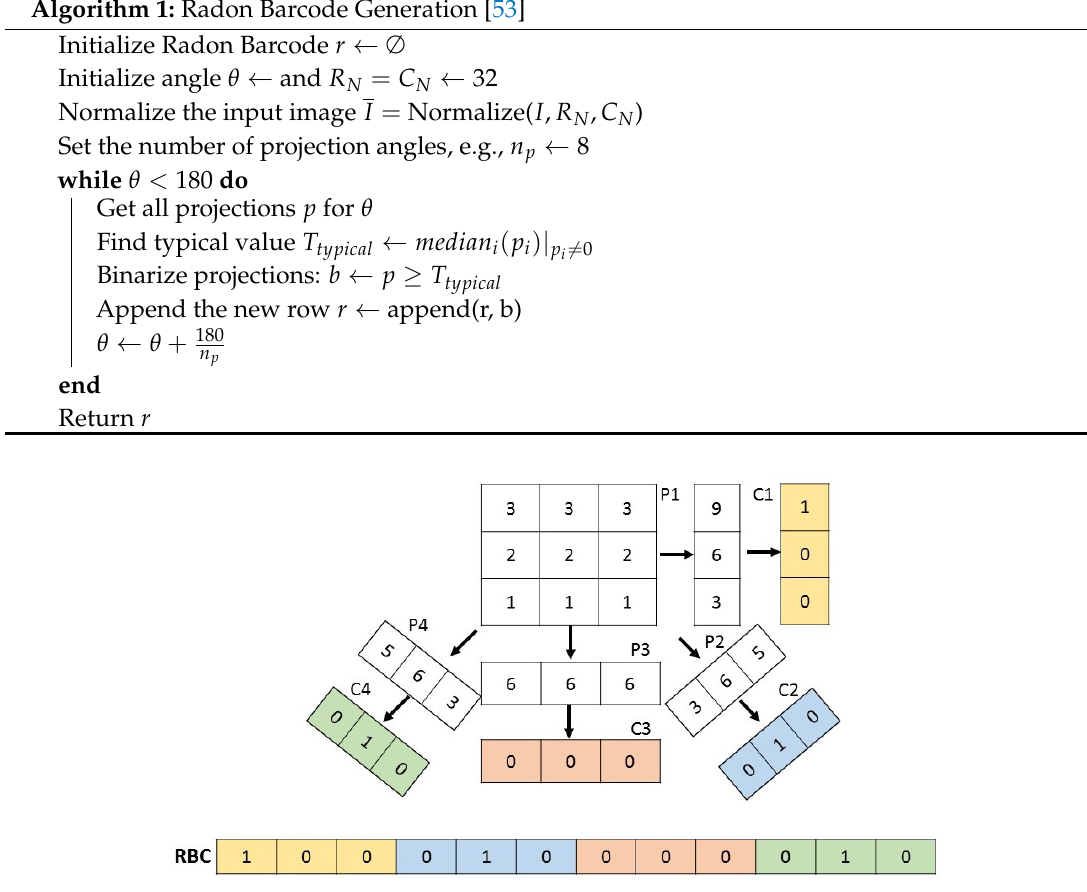
Figure 4. Graphic example of an RBC